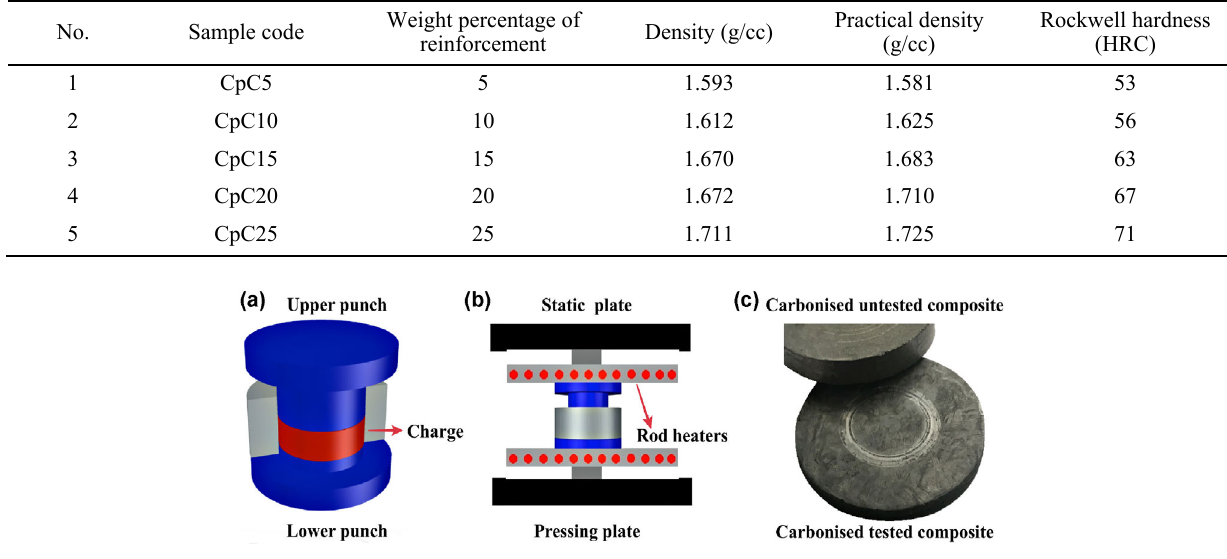
Fig. 2 (a) CAD representation of the mild steel die, (b) CAD representation of the hot compression molding, and (c) composite sample before and after the wear